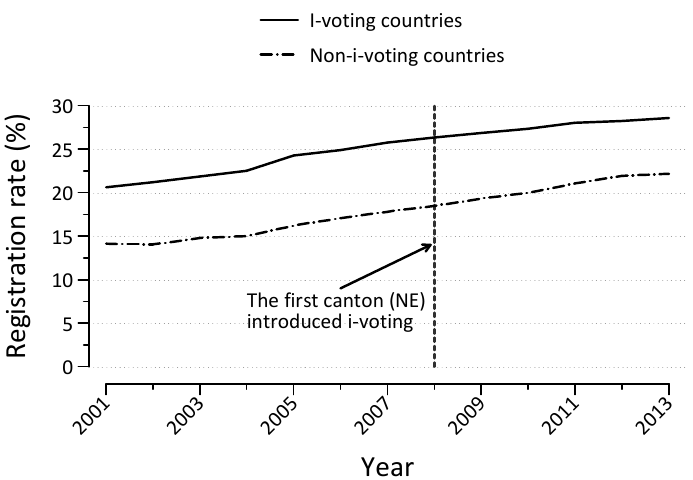
Figure 4: Registration rates by i-voting availability